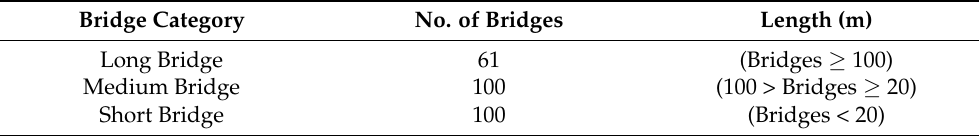
Table 1. List of bridges used in this study.